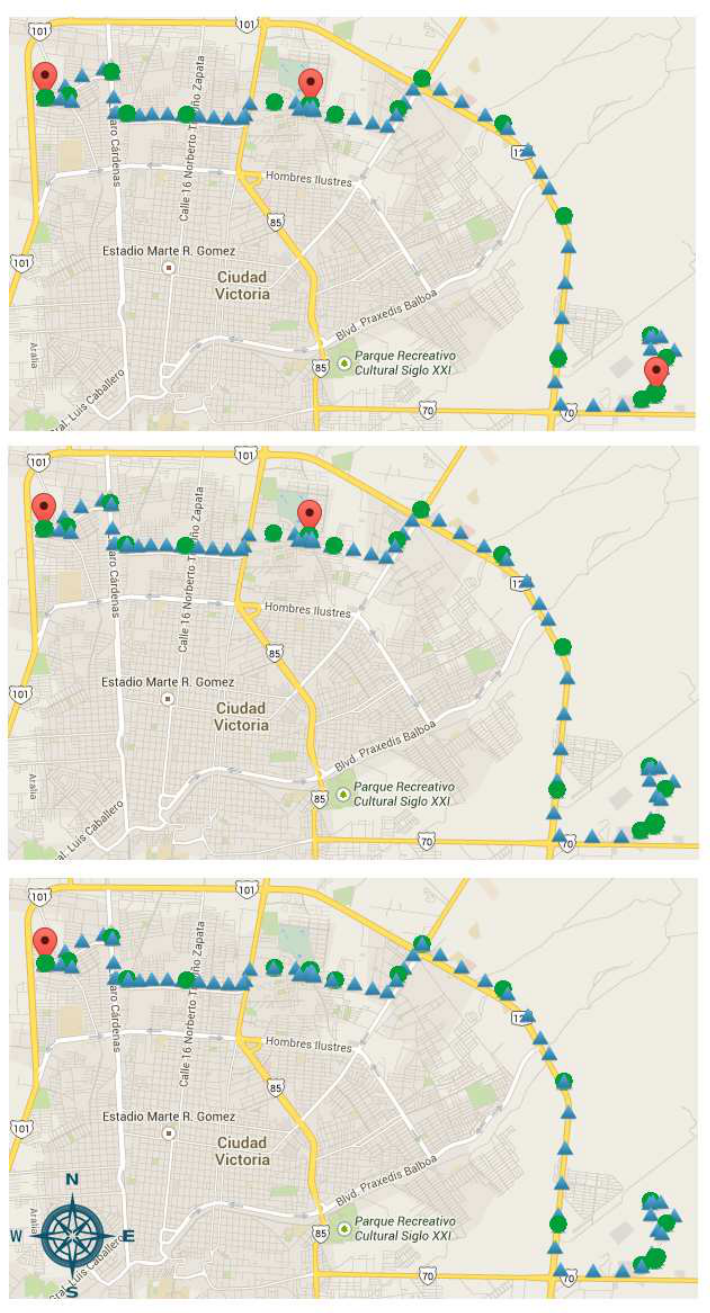
Figure 8. Stay region detection using the location point processing algorithm under temporal thresholds of 5, 10 and 15 min (from top to bottom) and a spatial threshold (three cases) of 100